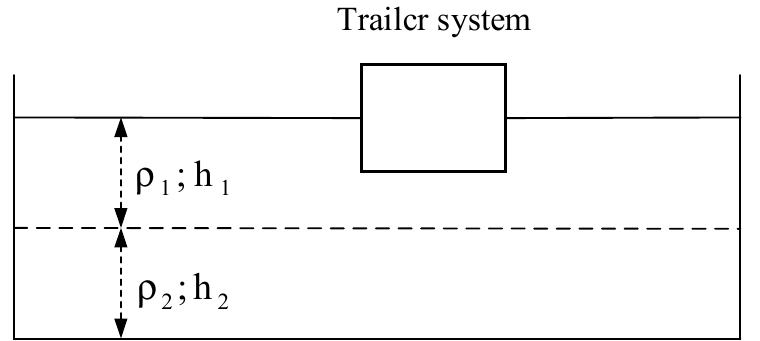
Figure 1. Experimental diagram for towing resistance of box structure.